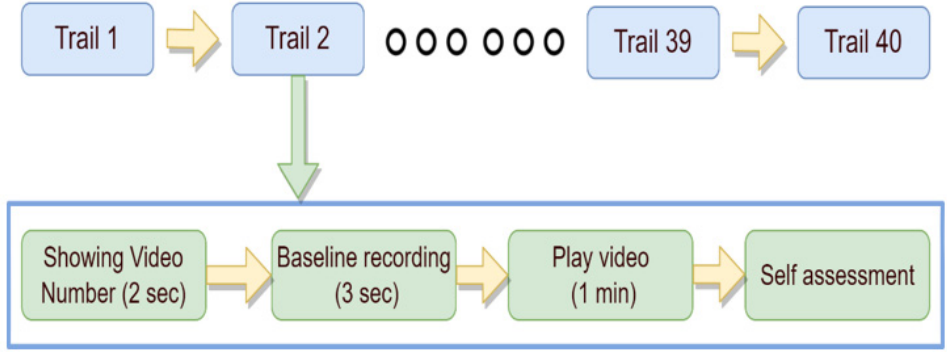
Figure 3. Experiment procedure of the DEAP for collection of EEG data.